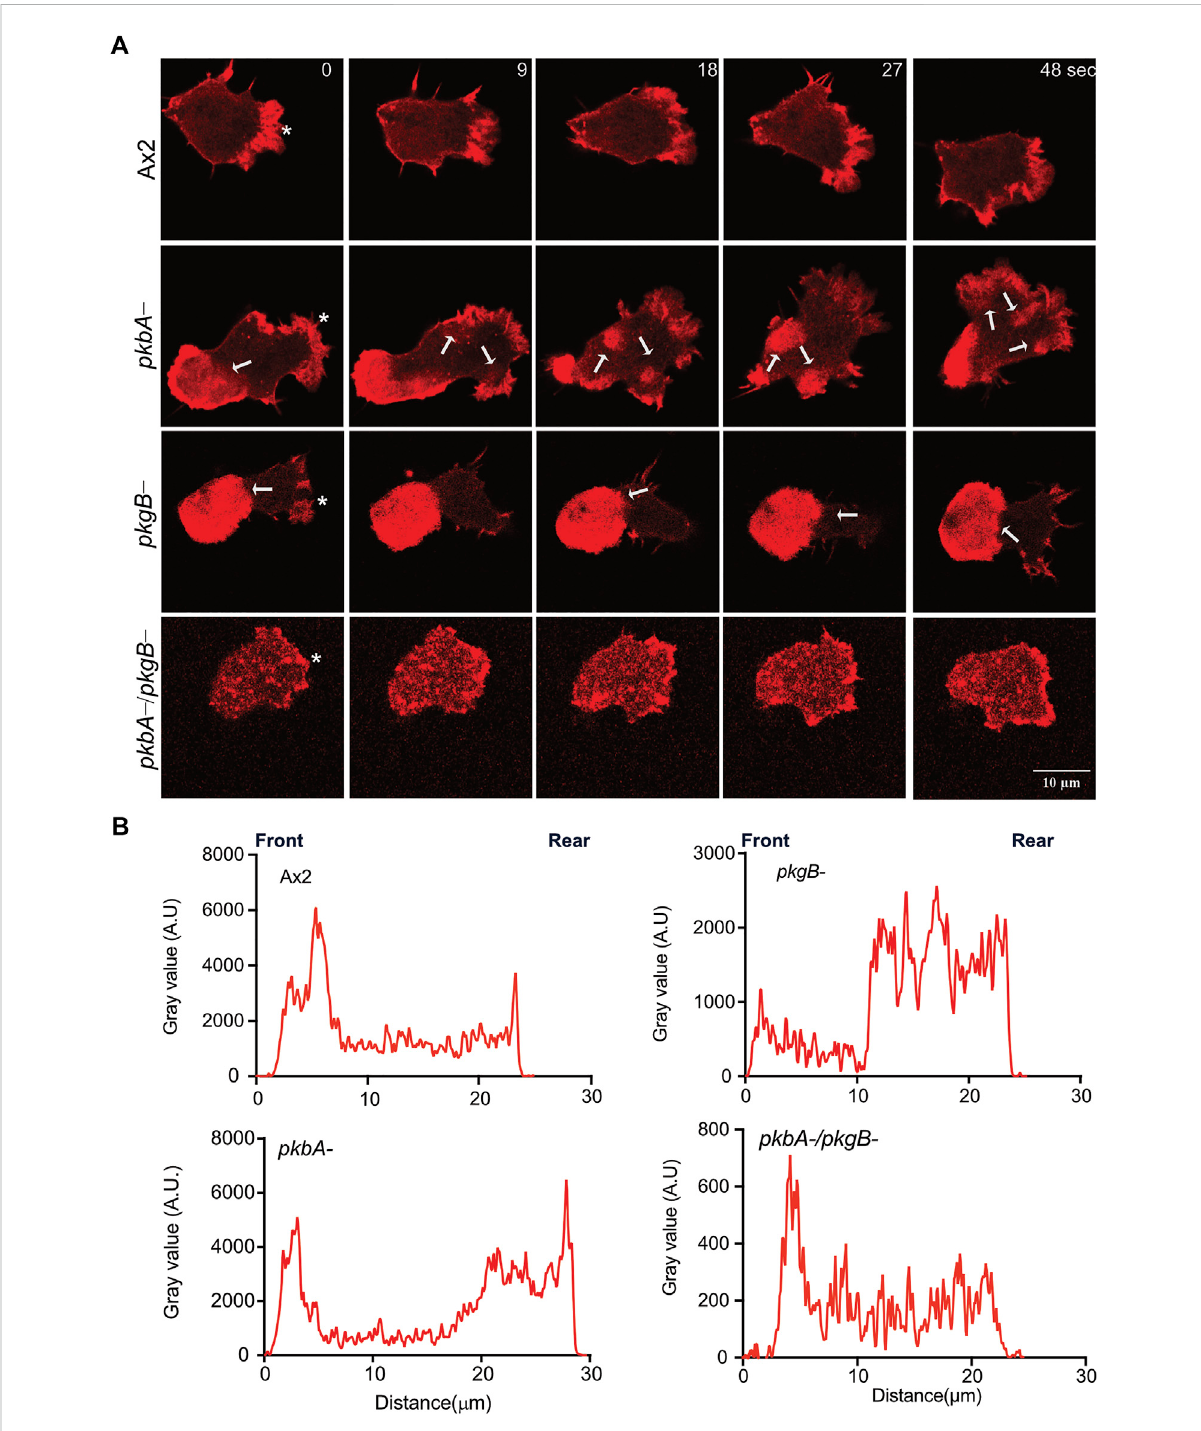
FIGURE 3 Actin localizes to Ax2 and pkbA - protrusions, but not in pkgB - and pkbA -/ pkgB -. (A) Subcellular localization of F-actin (Red). Life-act- mRFPmars2 was expressed in Ax2, and mutant cells. Cells were allowed to migrate under agarose mediated by a folate gradient and imaged by AiryScan confocal microscopy at a frame interval of 3 s (1f/3 s). Ax2 and pkbA - cells show F-actin in pseudopodia (asterisk). F-actin accumulation is absent in pkgB - protrusions, and highly reduced in pkbA -/ pkgB -. Static F-actin in the cell body is present in both pkbA - and pkgB -. (B) Quanti fi cation of the fl orescence intensities in cells. Using ImageJ, intensity pro fi le plots were generated by drawing a straight line across the cell. The amount of F-actin is similar in Ax2 and pkbA -, but reduced in pkgB - and pkbA -/ pkgB - cells, where F-actin is mostly localized in the cell body. Images are representative of ≥ 10 cells from 3 independent